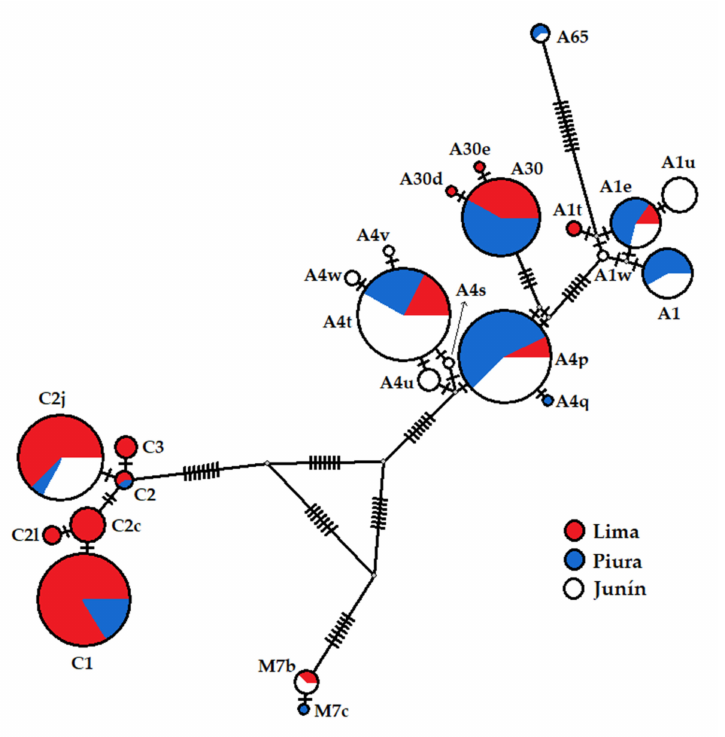
Figure 4. Haplotype network based on tRNAleu-cox2 sequences of Apis mellifera from Lima, Piura, and Jun í n. Hypothetical (unsampled or extinct) haplotypes are indicated as gray-filled circles. The size of circles is proportional to the observed haplotypes frequencies. Colors depict the proportion of individuals identified from the three Peruvian regions sharing the haplotype. Each tick represents a mutational step between haplotypes.